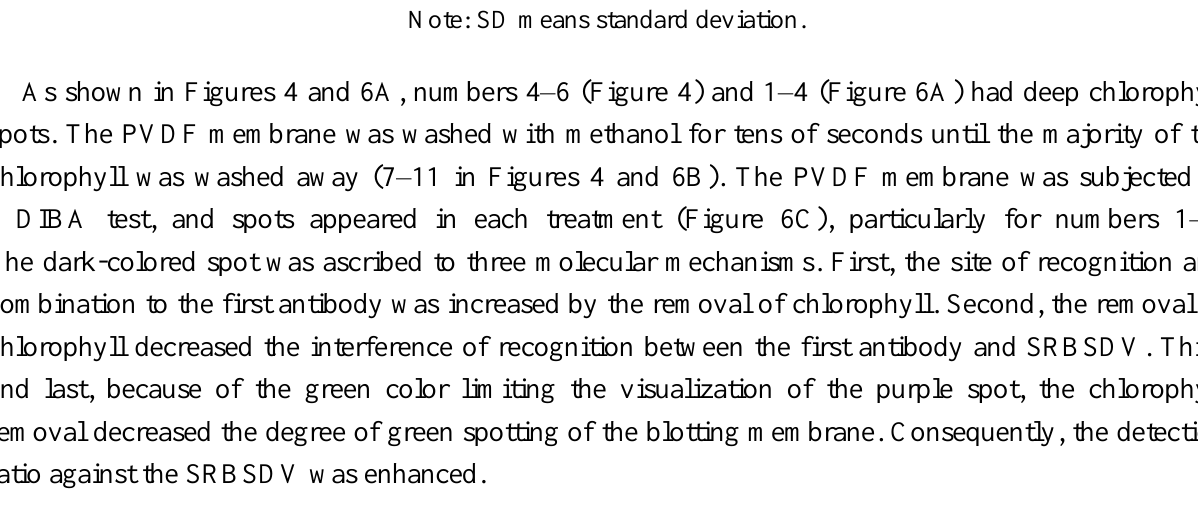
Figure 6. DIBA test completed in the PVDF membrane. ( A ) The dry effect of rice extraction in carbonate-coating buffer loading onto the PVDF membrane. ( B ) The effect of washing the membrane by methanol. ( C ) The coloration effect of the PVDF membrane with nitro-blue tetrazolium (NBT) and 5-bromo-4-chloro-3-inodlyl-phosphate (BCIP). Numbers 1 and 2 represent SRBSDV-infected rice in the greenhouse. Numbers 3 and 4 represent SRBSDV-infected rice acquired from Yuanjiang, Yunnan in 2011. Numbers 5 and 6 represent SRBSDV-infected rice acquired from Shidian, Yunnan in 2011. Numbers 7 and 8 represent SRBSDV-infected rice acquired from Dushang, Guizhou in